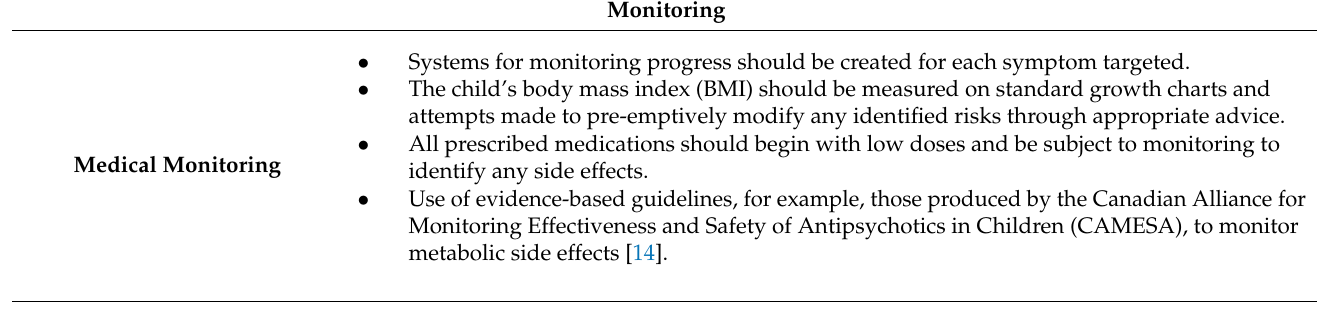
Table 4. Recommendations for monitoring.